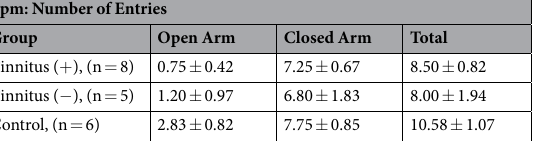
Table 1. Number of open- and closed-arm, and total arm entries for the tinnitus( + ), tinnitus( − ), and control groups. Data are presented as mean ± standard error of the mean. Notably, the number of total-arm entries was not significantly lower in tinnitus( + ) or tinnitus( − ) rats compared to controls, indicating that mobility was not impaired by blast